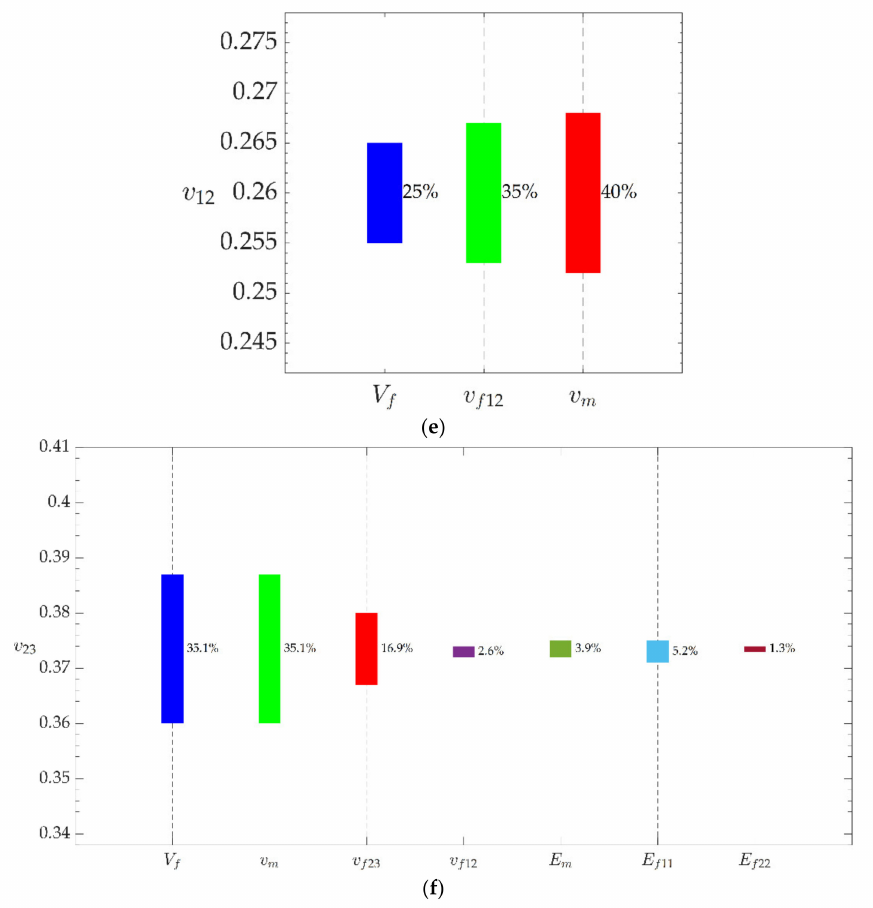
Figure 3. The effect of input parameters on the range of ( a ) the E 11 , ( b ) the E 22 , ( c ) the G 12 , ( d ) the G 23 , ( e ) the ν 12 , and ( f ) the ν 23 for the 21xK43-LY556 composite ply. The main parameter varied within ± 5% of its nominal value while the other parameters were kept equal to the nominal